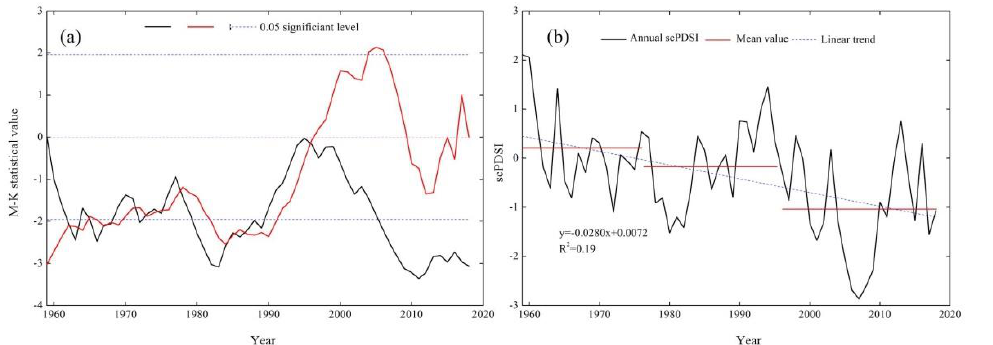
Figure 4. Abrupt changes ( a ) and annual trend ( b ) based on the scPDSI in the whole Mongolian Plateau from 1959 to 2018.